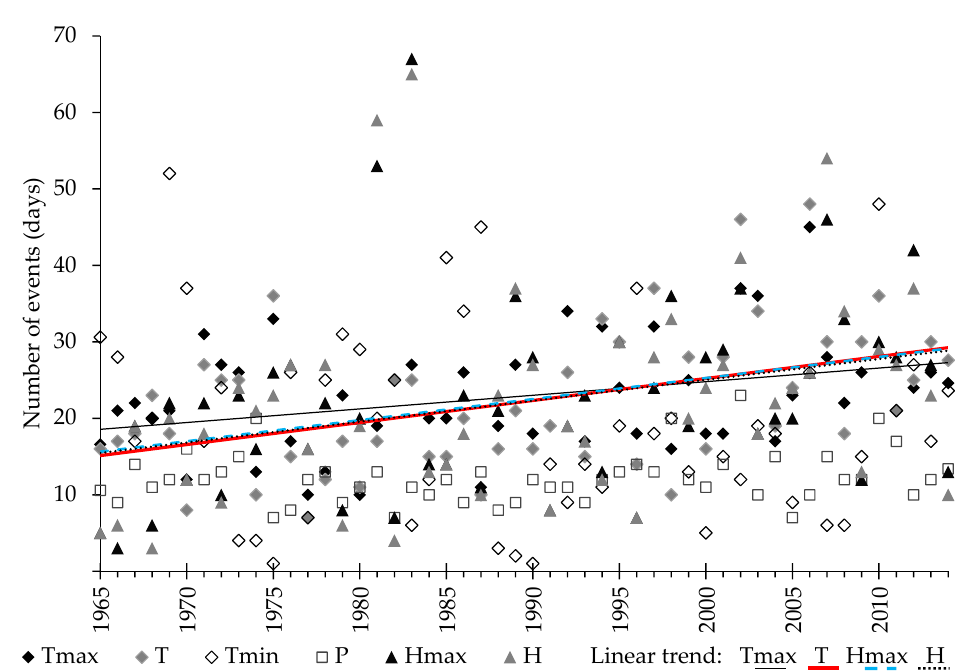
Figure 4. Occurrence of extreme hydrometeorological events in the Polish Baltic coastal zone.